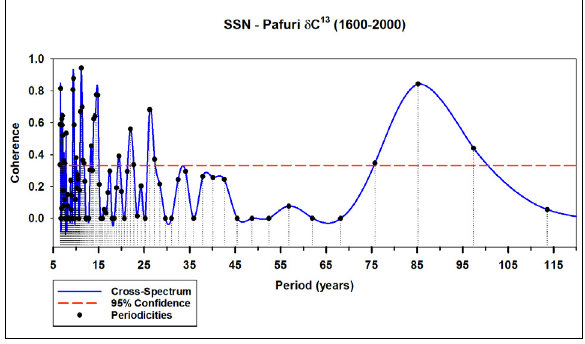
A cross-spectral analysis between annual mean sunspot 13 C data between 1600 AD and 2000 numbers (ssn) and δ